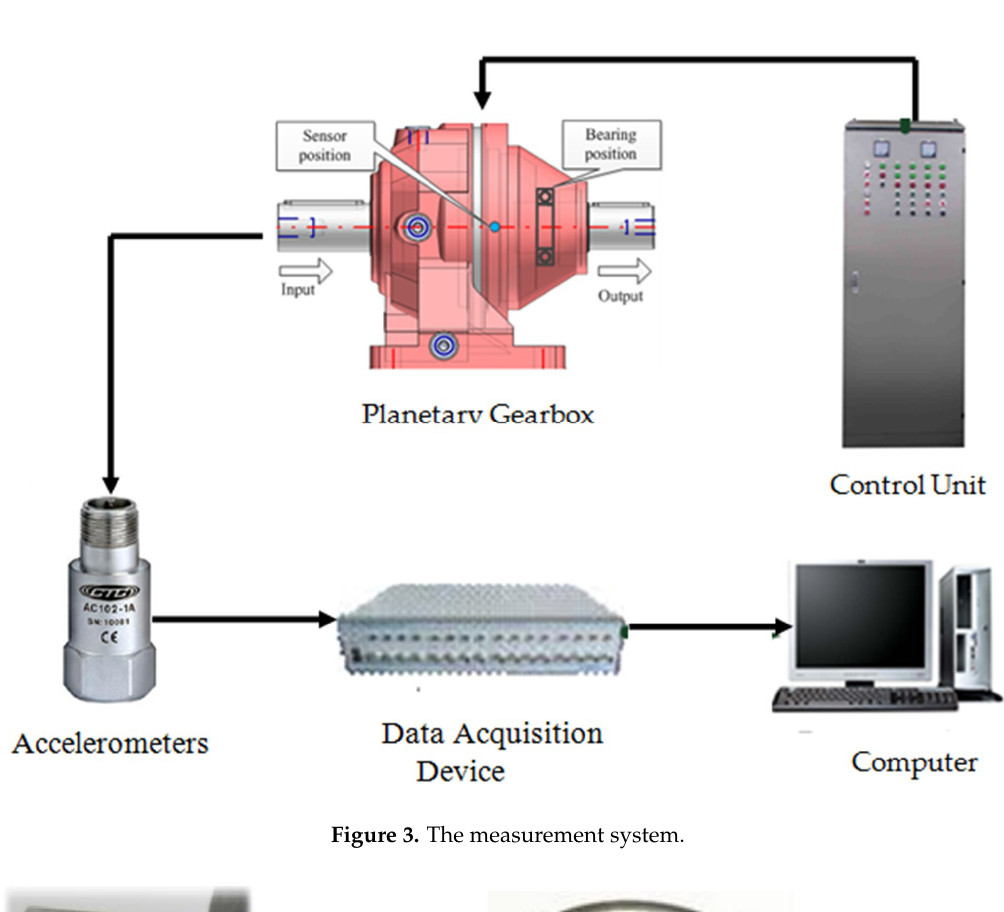
Figure 2. The planetary gearbox test rig.